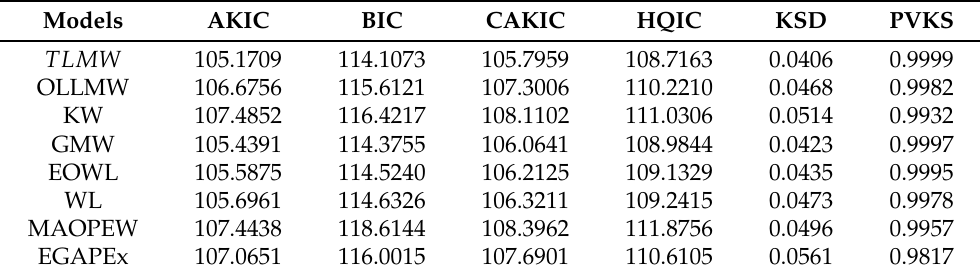
Figure 25. PP and QQ for TLMW model for single carbon fibers data. Table 20. Discrimination criteria and KS test of the TLMW model parameters for single carbon fibers.